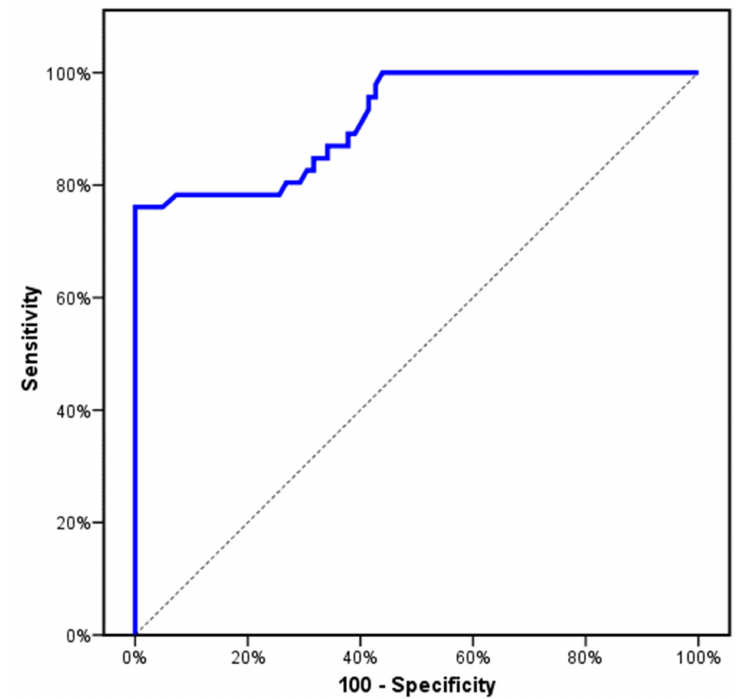
Figure 3. ROC curve for relative expression of CCL2 to discriminate MF patients (PMF and Post- PV/ET-MF) ( n = 46) from PV and ET ( n =